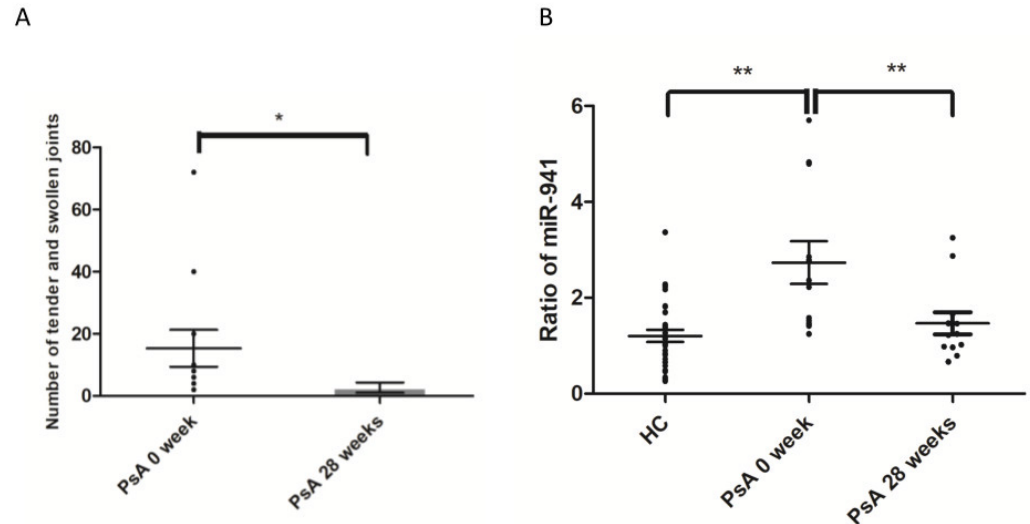
Figure 5. Reduced miR-941 expression in CD14 + monocytes from PsA patients after successful biologics treatment. The expression levels of miR-941 were measured in CD14 + monocytes from HCs and PsA patients before and after successful biologic treatment. ( A ) The total number of tender and swollen joints in PsA patients were measured before and 28 weeks after biologics treatment. ( B ) The expression levels of miR-941 were measured in CD14+ monocytes from 31 NCs and 12 PsA patients before and after 28 weeks of biologics treatment using qRT-PCR. * p < 0.05; ** p < 0.01.